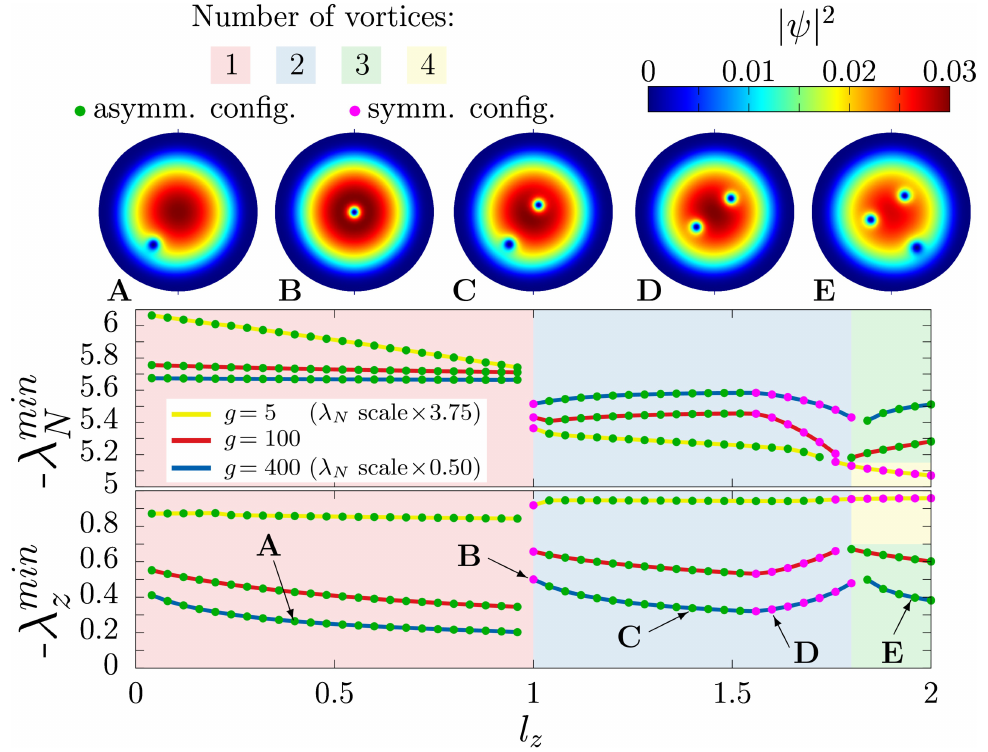
Figure 2 . Minimum energy states for angular momenta l z ∈ (0 , 2] . The bottom row shows the dependence of the multipliers λ min and λ min on the angular momentum l z for g = 5 , 100 and 400 z N